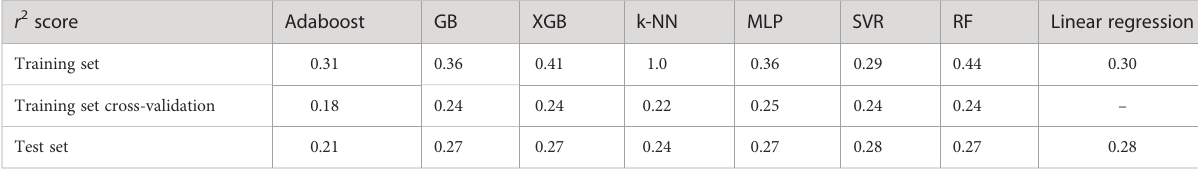
Table 2 The r 2 scores for seven ML models and linear